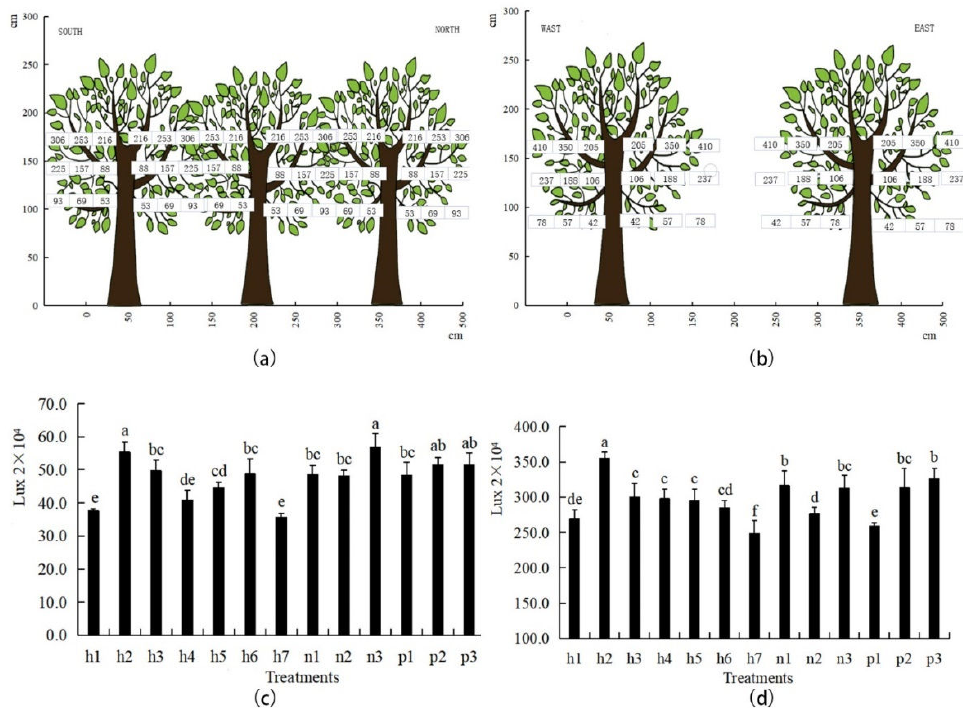
Figure 2. Light distribution characteristics of different fertilization treatments. ( a ) Leaf canopies’ structure and light distribution during individual growth period of jujube. Numerical values repre- sent light intensity. ( b ) Leaf canopies’ structure and light distribution during individual growth period of interrow jujube. ( c ) Different fertilization treatments and jujube tree interior canopy light intensity (ICLI). (mean ± SD, n = 12). ( d ) Different fertilization treatments and jujube tree external canopy light intensity (ECLI) (mean ± SD, n = 12). Mean totals with a common letter are not different ( p < 0.05) by ANOVA for the ranking test.